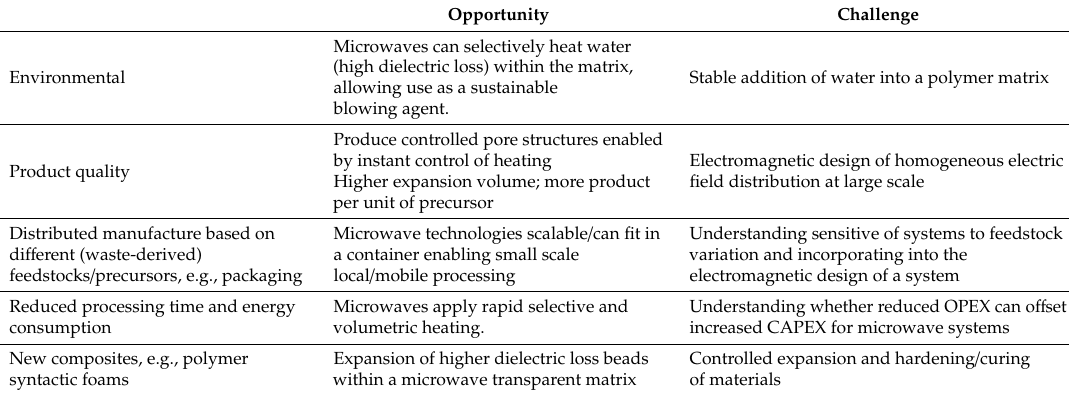
Table 3. The possible value proposition of microwave foaming